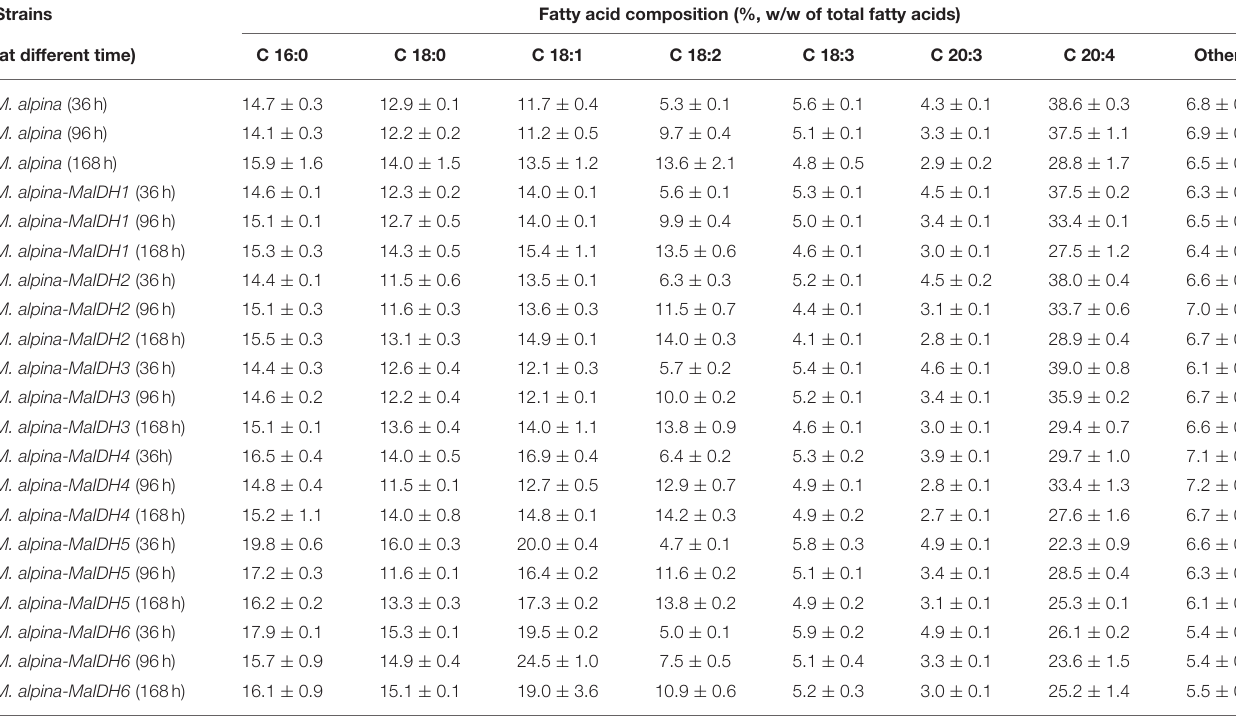
TABLE 2 | Fatty acid composition (%, w/w of total fatty acids) of the recombinant strains during the fermentation. Strains Fatty acid composition (%, w/w of total fatty acids)